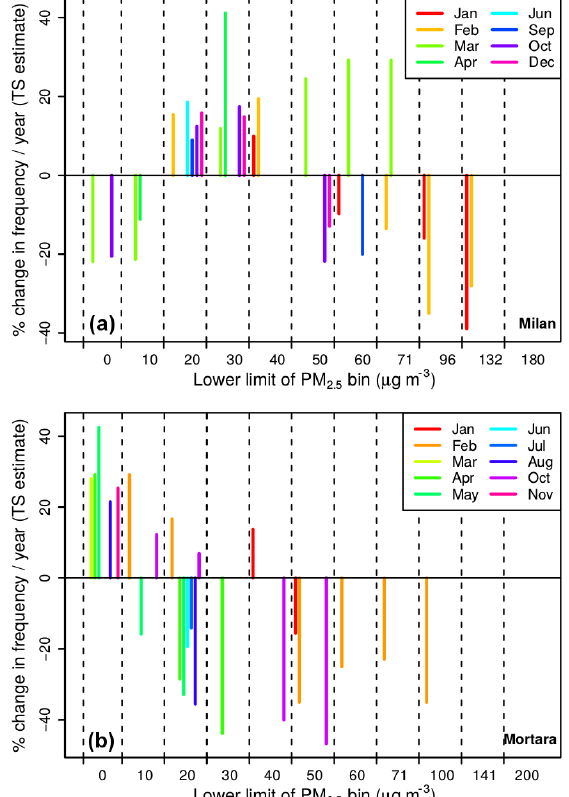
Figure 3. Significant changes in monthly frequency distribution of PM 2 . 5 at Milan (a) and Mortara (b)